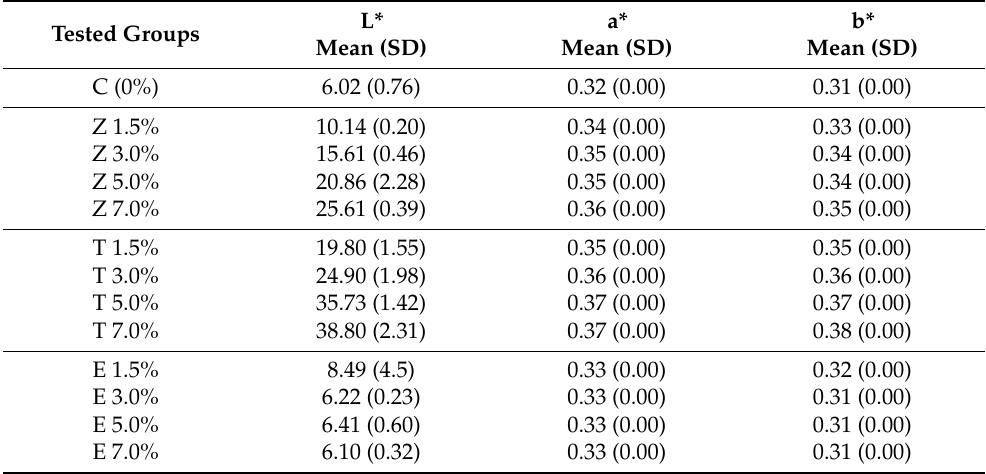
Table 3. Mean ( ± SD) of baseline CIELab colour measurements for each tested group after immersion in distilled water for 24